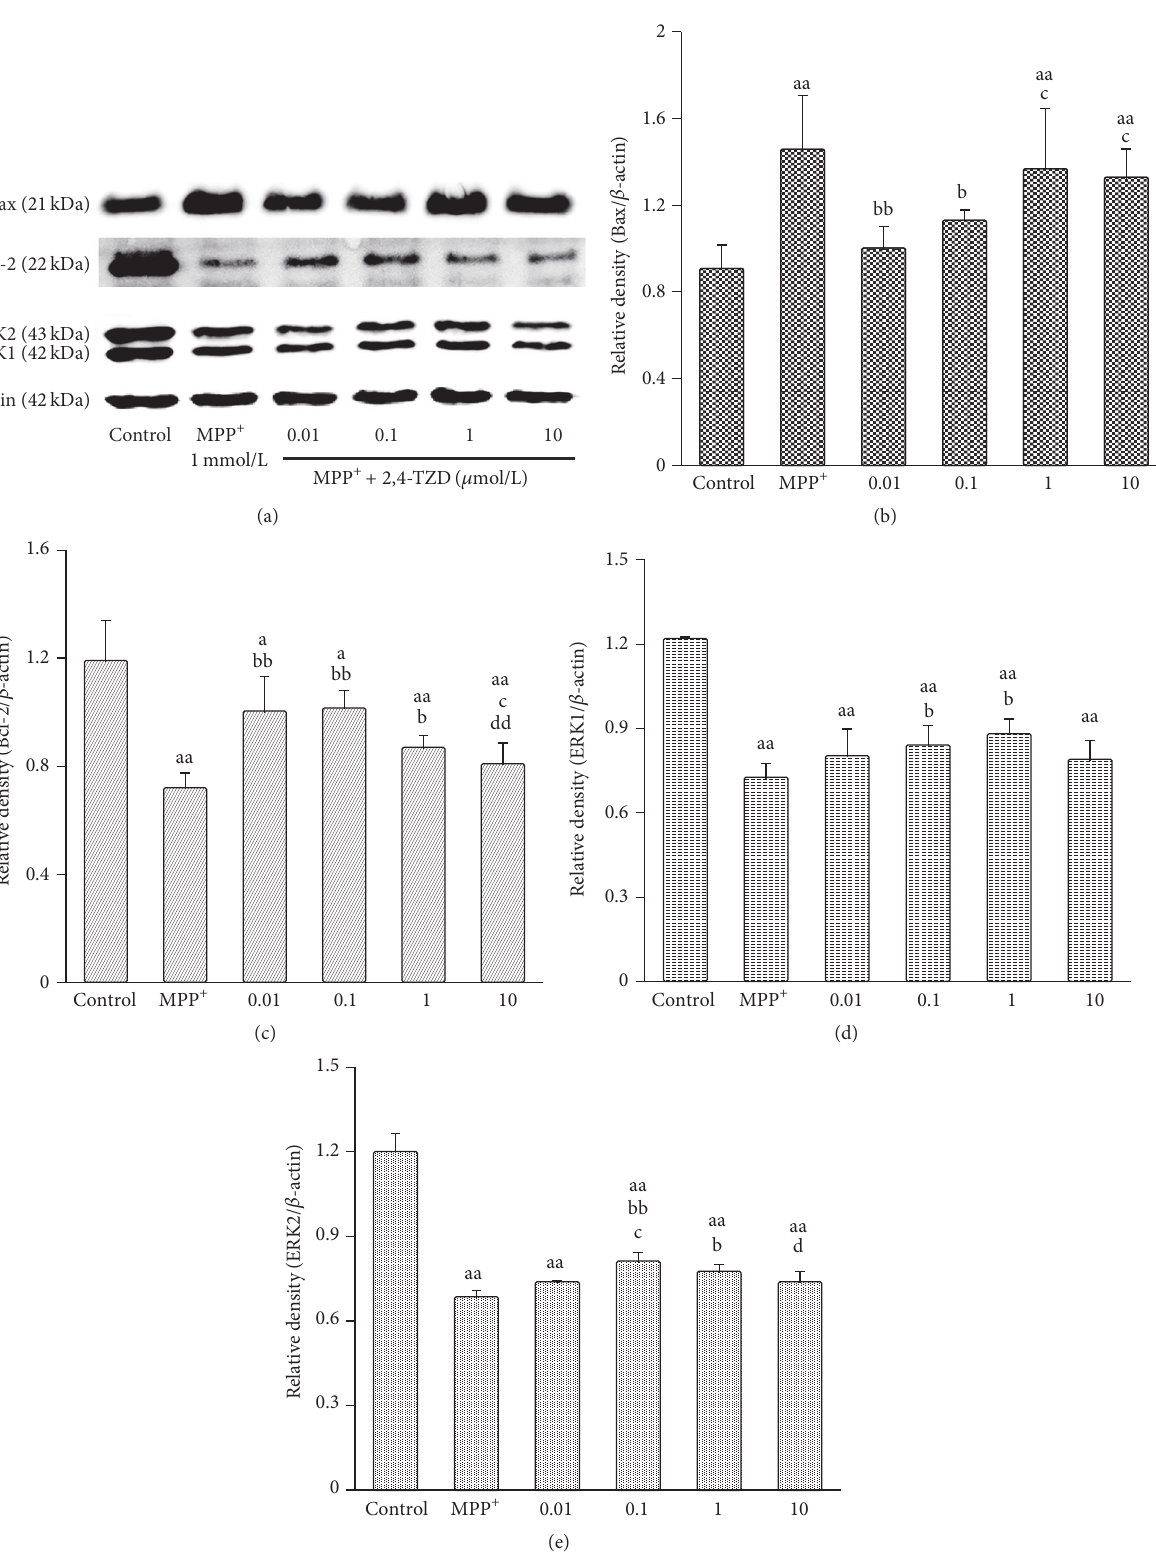
Figure 7: Effect of thiazolidinedione on apoptosis and levels of antiapoptosis proteins. (a) The expression of Bax, Bcl-2, and ERK in different groups; 𝛽 -actin was used as the loading control. (b)–(e) express the protein levels of Bax, Bcl-2, and ERK. “a” indicates 𝑃 < 0.05 and “aa” indicates 𝑃 < 0.01 , compared with control group; “b” indicates 𝑃 < 0.05 and “bb” indicates 𝑃 < 0.01 , compared with MPP + group; “c” indicates 𝑃 < 0.05 and “cc” indicates 𝑃 < 0.01 , compared with 0.01 𝜇 mol/L 2,4-TZD group; “d” indicates 𝑃 < 0.05 and “dd” indicates 𝑃 < 0.01 , compared with 0.1 𝜇 mol/L 2,4-TZD